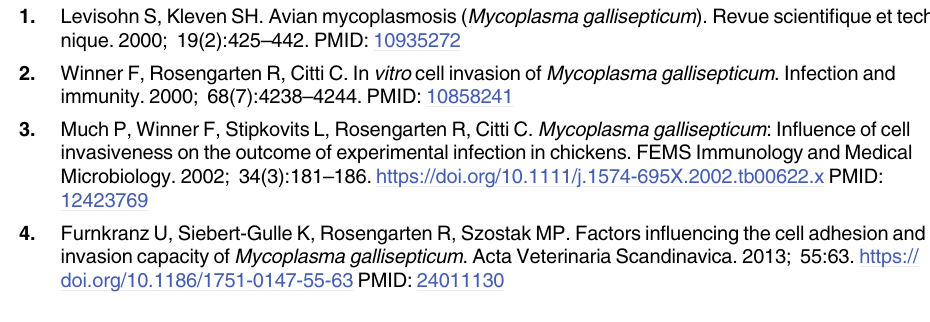
S1 Fig. SDS-PAGE of recombinant E . coli containing pIGN, pIGN-PDHA, and pIGN-PDHB. Lane 1: E . coli BL21 (DE3) transformed with pET-28a (+) induced by IPTG; Lane 2: E . coli BL21 (DE3) containing recombinant plasmid pIGN-PDHA induced by IPTG; Lane 3: E . coli BL21 (DE3) transformed with the pIGN-PDHB induced by IPTG. Lane 4: E . coli BL21 (DE3) transformed with pIGN induced by IPTG. Red marks, expressed recombinant fusion protein.